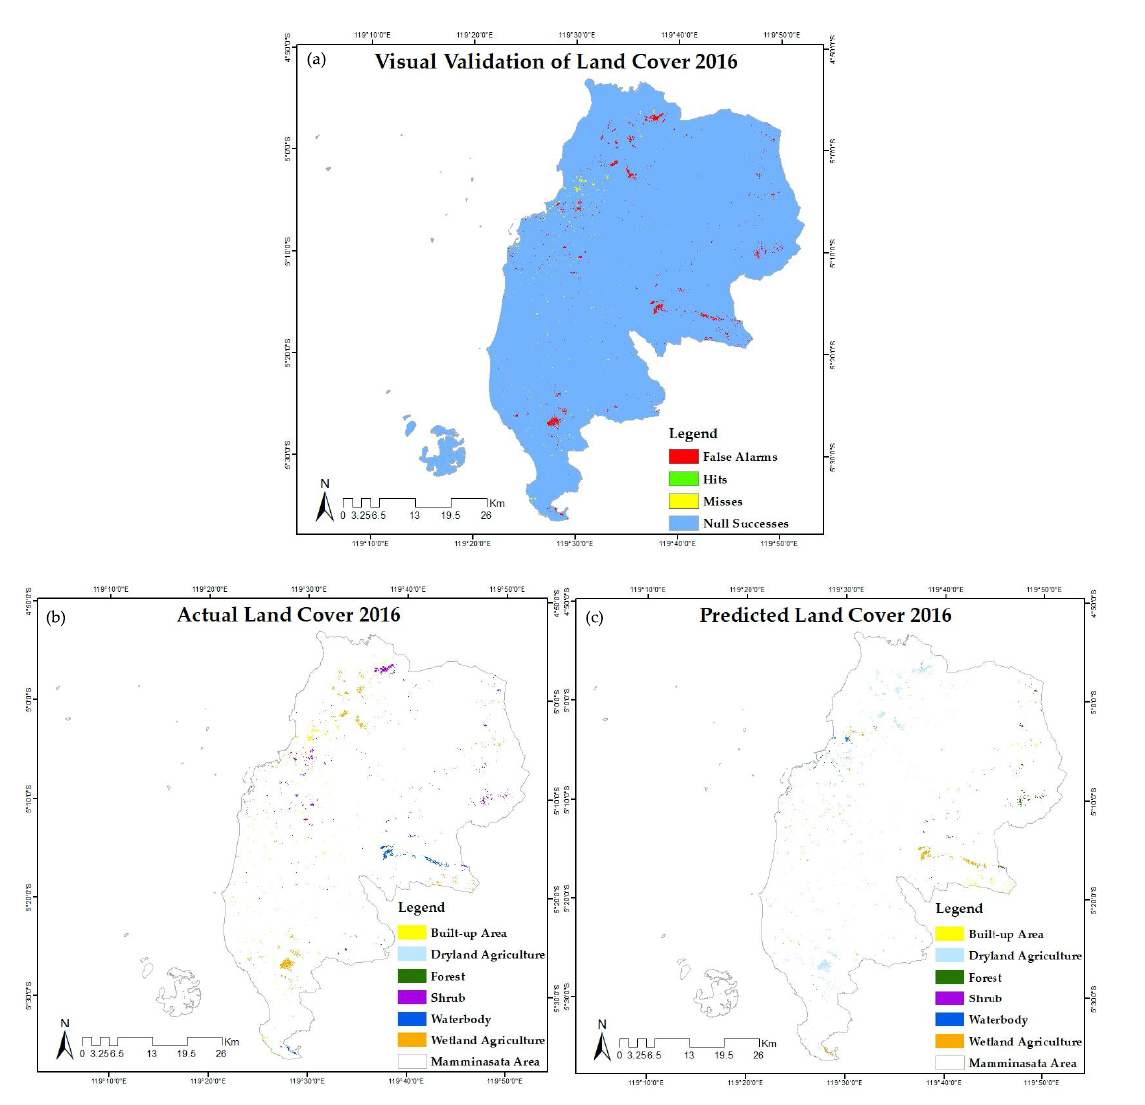
Figure 9. Visual validation ( a ); actual ( b ) and predicted land cover maps for 2016 for different areas ( c ). Statistical validation was carried out by comparing the whole area and different areas (areas of false alarms and misses). Table 6 shows the kappa values for the validation of the whole area and different areas. Pontius and Millones [60] revealed that the values of kappa for no information and grid-cell level location were somewhat more helpful than the values of kappa for stratum-level location and standard. Based on that, the results of accuracy can be accepted, and the model can be run for land cover prediction for 2031. Table 6. Accuracy test of change prediction. Table 6. Accuracy test of change